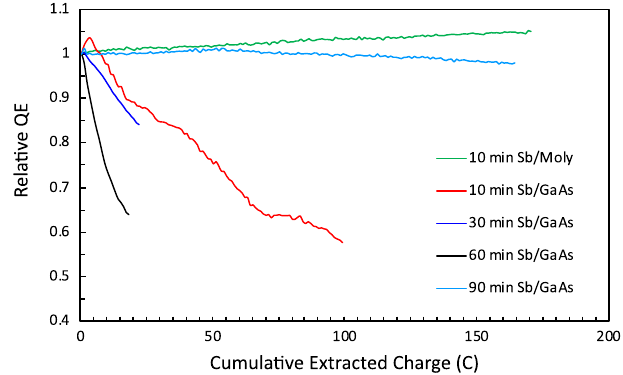
FIG. 10. Relative QE (relative to the initial value during lifetime measurement) versus the cumulative extracted charge for the five fabricated